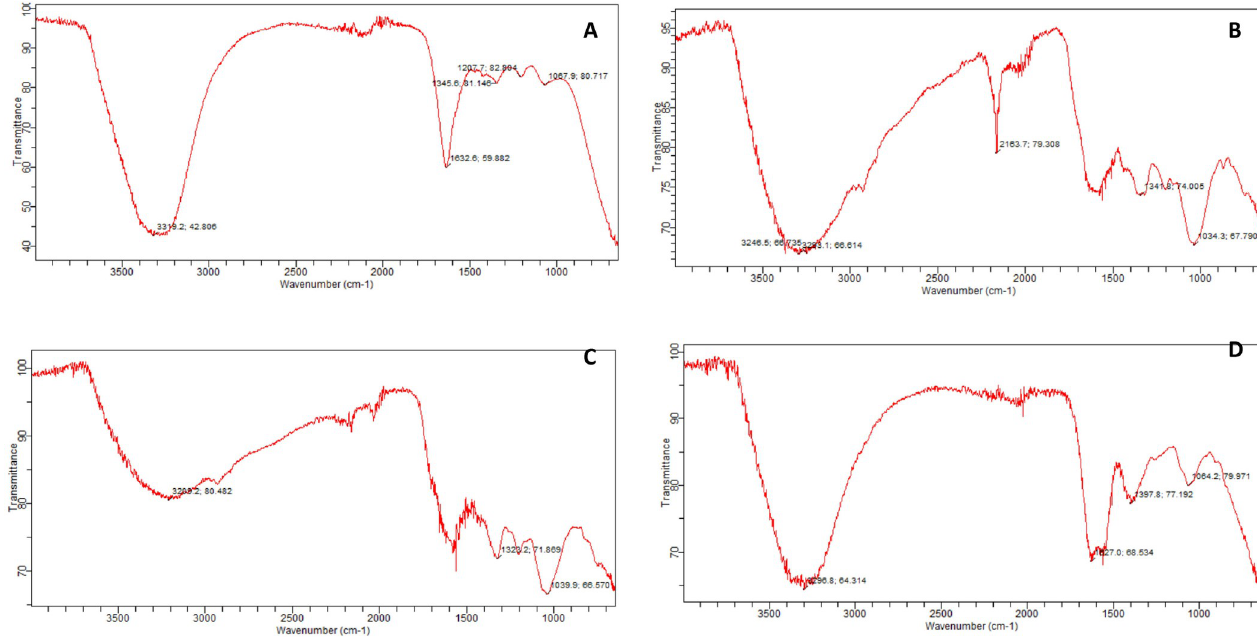
Fig 6. FTIR spectrum of (A) AgNPs prepared by using 10 mL (2 mM solution) of AgNO 3 with 30 mL of R . communis leaves extract (B) ZnO NPs prepared by using 10 mL (2 mM solution) of ZnSO 4 with 30 mL of R . communis leaves extract (C) CuO NPs prepared by using 10 mL (2 mM solution) of CuSO 4 with 30 mL of R . communis leaves extract (D) FeO NPs prepared by using 10 mL (2 mM solution) of FeCl 3 with 30 mL of R . communis leaves extract.